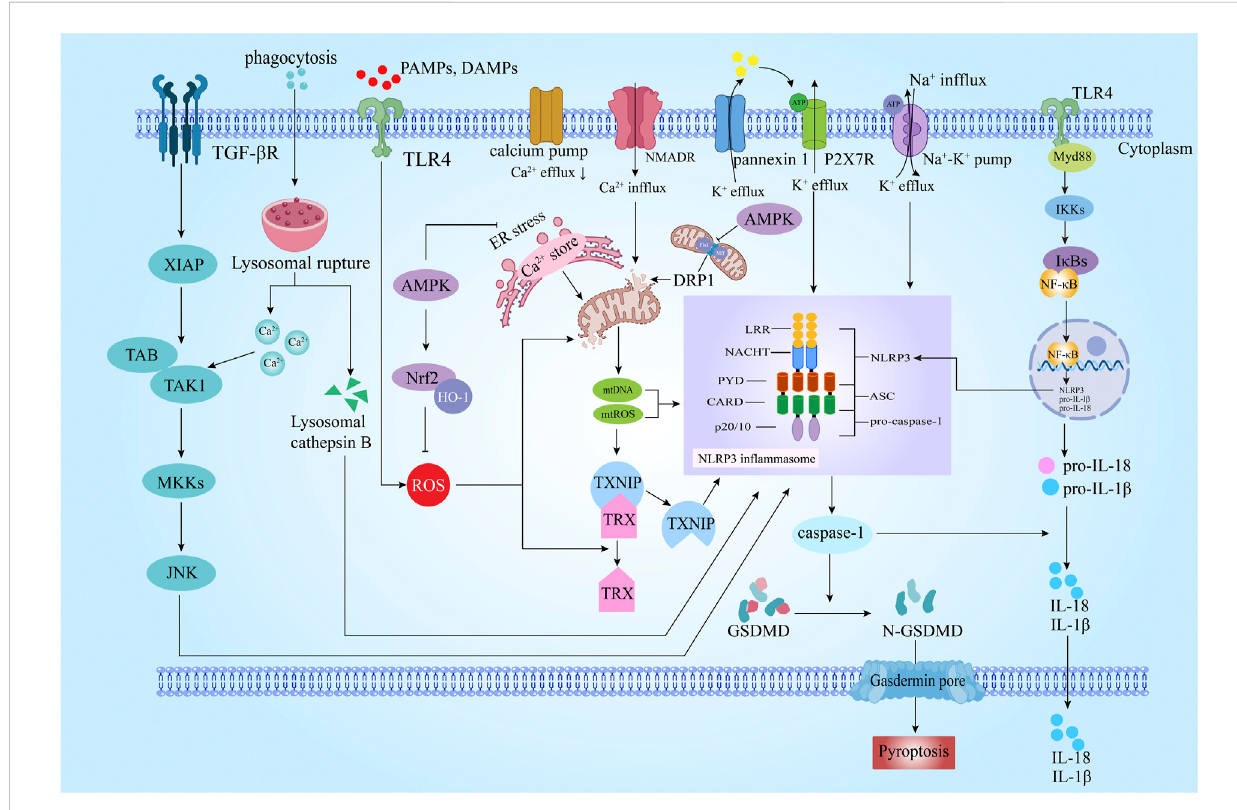
Schematic diagram of the molecular mechanism of pyroptosis in ischemic stroke (IS). Pyroptosis is a kind of programmed cell death process mediated by nucleotide-binding oligmerization domain-like receptor protein 3 (NLRP3) in fl ammasome and activated by Caspase-1) . It has the characteristics of both apoptosis and necrosis NLRP3. The initiation of the NLRP3 in fl ammasome involves a series of signaling pathways, such as TLR4/ NF- κ B/NLRP3, ROS/TXNIP/NLRP3, AMPK/NLRP3, DRP1/NLRP3, TAK1/JNK/NLRP3. TGF β : transforming growth factor- β ; XIAP: X-linked inhibitor